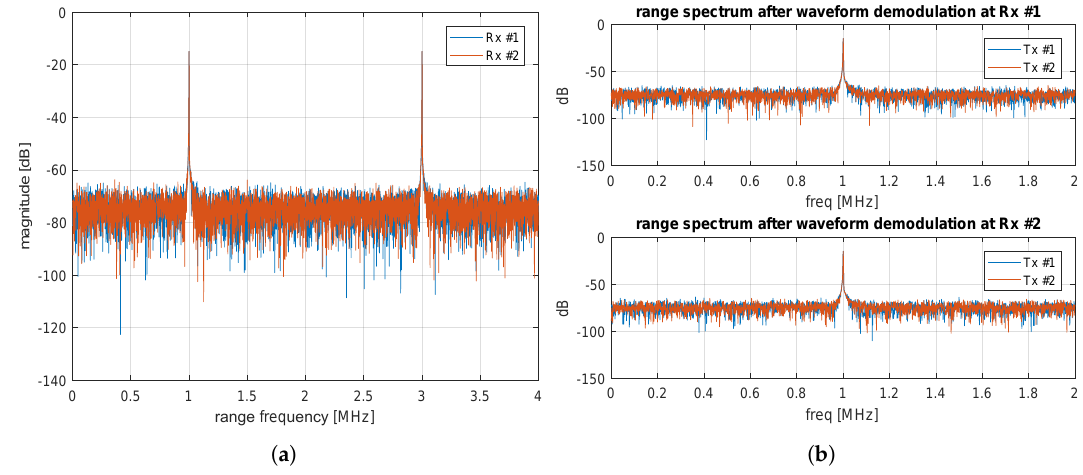
Figure 12. Results of BFD FMCW waveform demodulation: ( a ) before demodulation; ( b ) after demodulation.